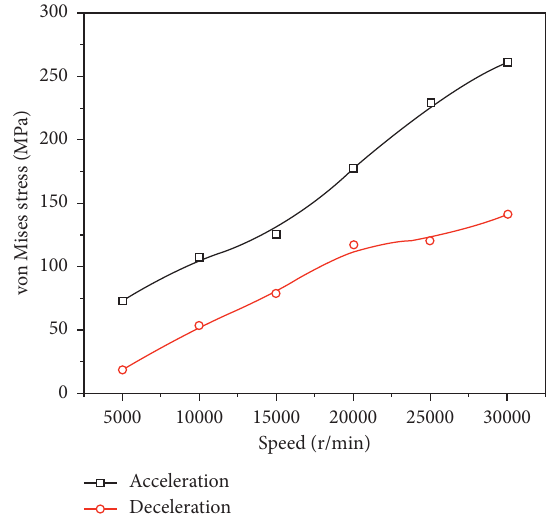
Figure 11: Influence of inner acceleration on cage stress at the stage of start-up and